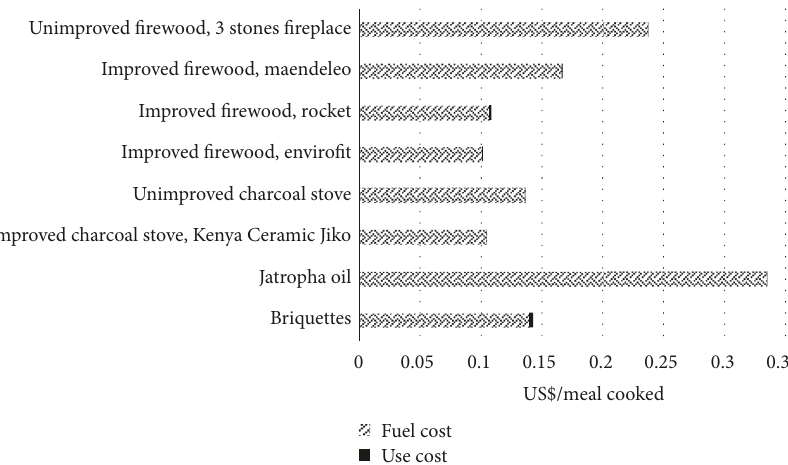
Figure 3: Life cycle costs per meal cooked (US$) for the different energy value chains in urban Kitui.